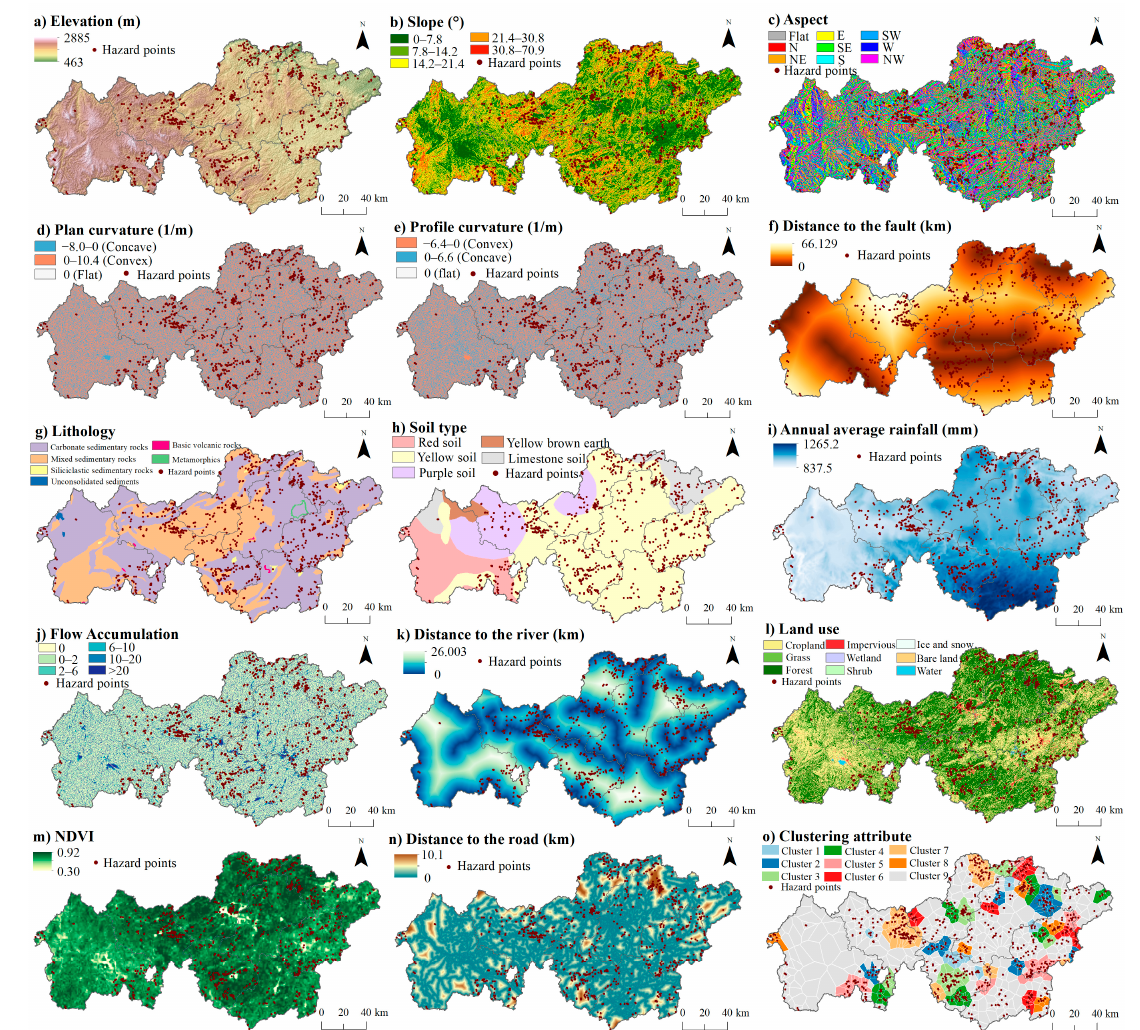
Figure 6. The spatial distribution map of affecting factors in Bijie. Table 1. Introduction of affecting factors*.